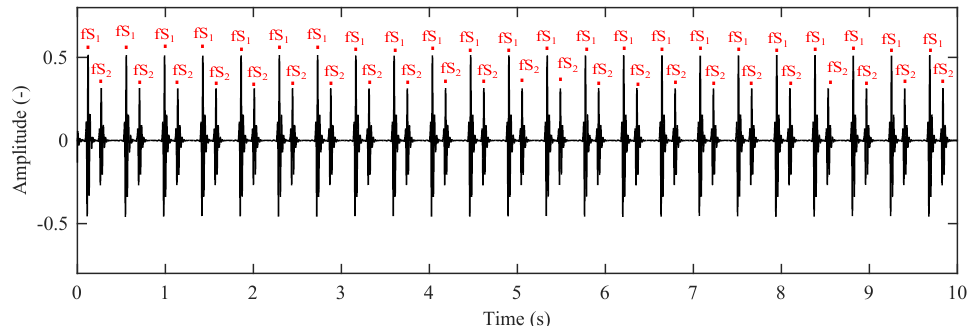
Figure 12. Modelled reference (ideal) signal represented by IS A in the abdominal region without a maternal component (fHR ∈ <80–155> bpm, GA = 35 weeks, fetus position: Right Occiput Posterior